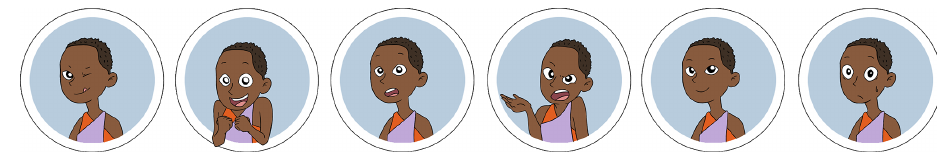
Figure 8. Facial expressions used for the teenage girl character in the African edition of the game, each representing a specific emotional tone: mild happiness, excited happiness, mild surprise, disgust, quiet happiness, and fear (left to right).